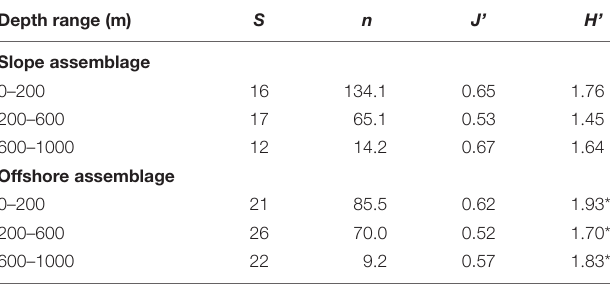
TABLE 2 | Evenness and diversity indices for nighttime slope and offshore assemblages of euphausiids. Depth range